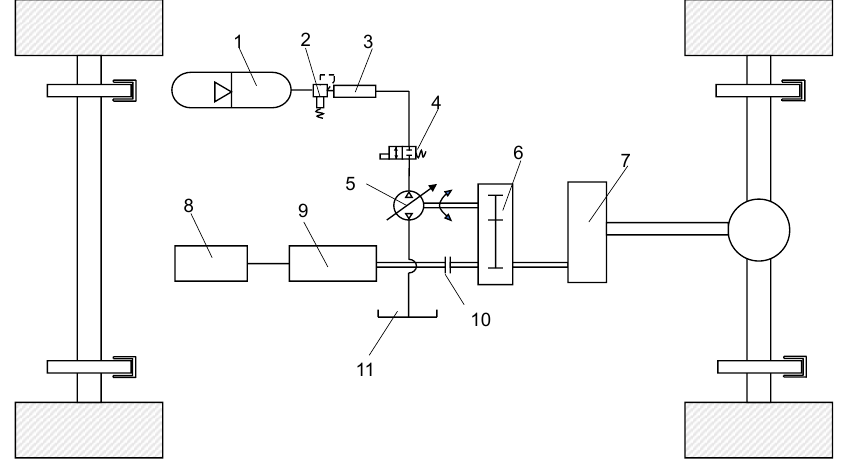
Figure 1. Parallel hydraulic hybrid power structure: (1) accumulator; (2) relief valve; (3) pressure sensor; (4) electromagnetic digital valve; (5) variable hydraulic pump/motor; (6) torque coupler; (7) gearbox; (8) battery; (9) motor; (10) electromagnetic clutch; (11) tank.